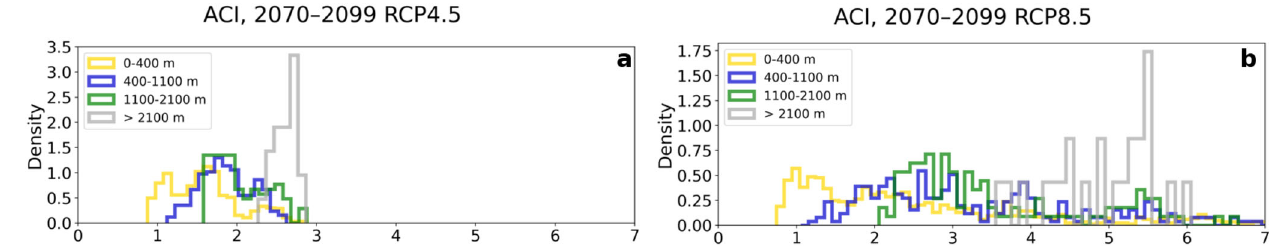
Fig. 5 Distribution of future changes in aridity, by altitude level, in the two scenarios analyzed. Aridity Change Index (ACI) for 2070 – 2099 RCP4.5 ( a ) and RCP8.5 ( b ) expressed as histograms. The altitude levels are indicated in the legend of